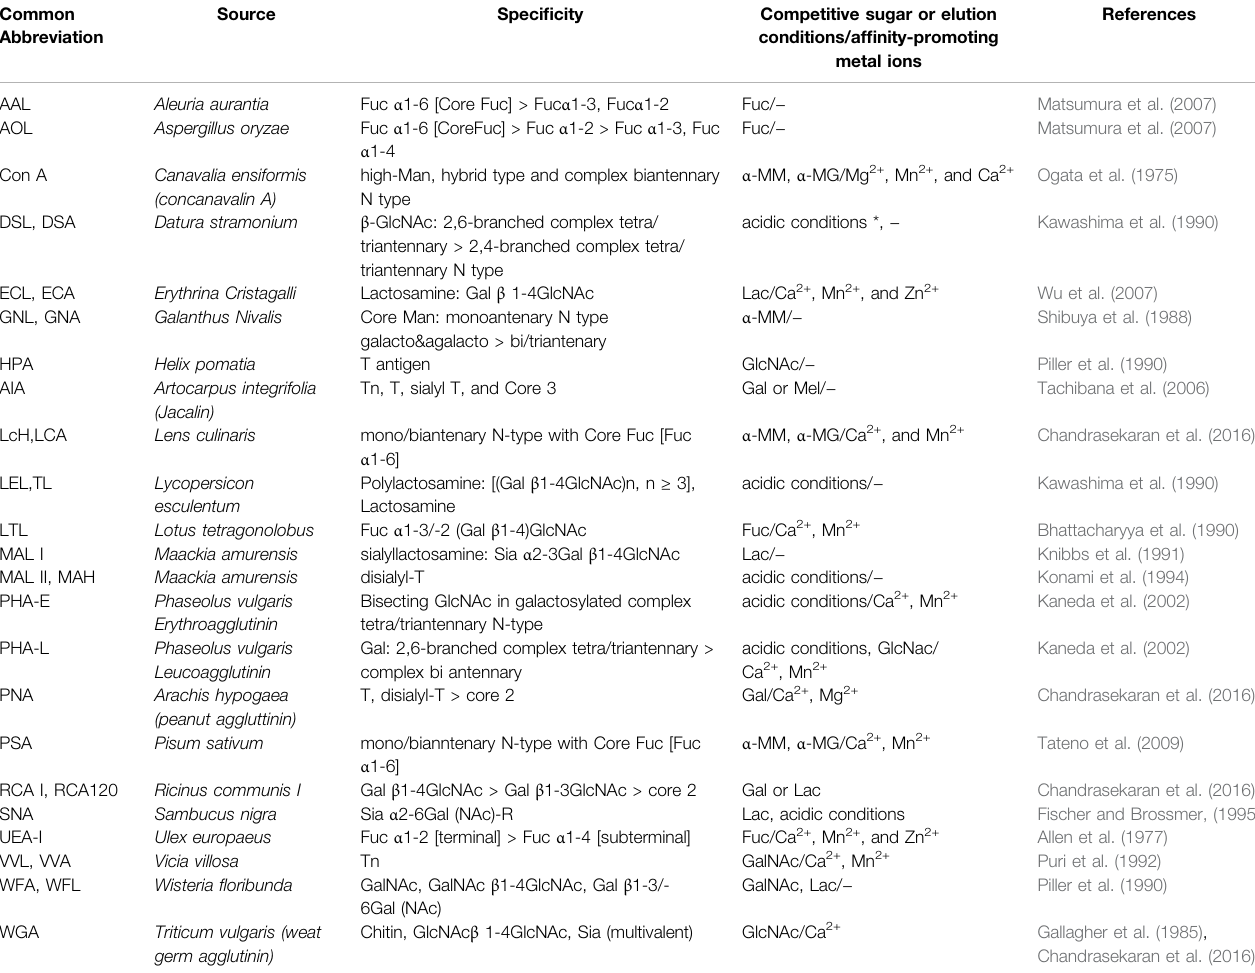
TABLE 1 | Most commonly used lectins for the enrichment of glycoproteins and glycopeptides. Common